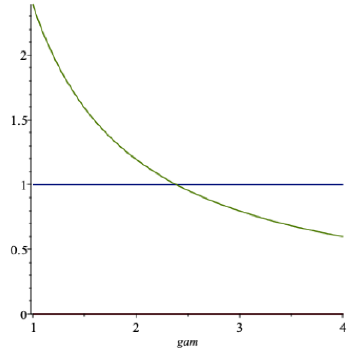
Figure 3. ϕ as a function of γ